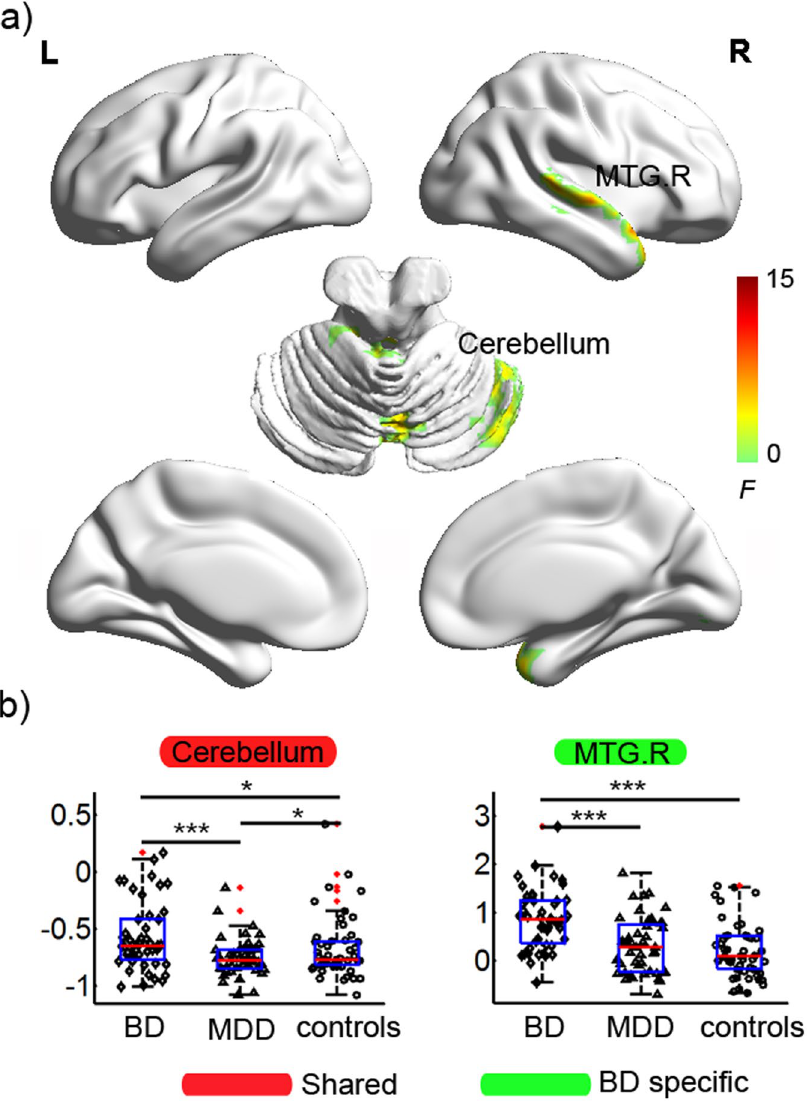
Figure 1. Statistical results for the lFCS in the BD, MDD, and healthy controls. ( a ) Clusters showing significant group effects ( p < 0.001 Alphasim corrected, ANCOVA). The brain surfaces were visualized using BrainNet Viewer (http://www.nitrc.org/projects/bnv/). ( b ) Post-hoc analyses of the lFCS for these significant clusters. The ‘BD’ type indicates that the lFCS in the cluster was specifically altered in the BD patients but not in the MDD patients. The ‘shared’ type indicates that the cluster with altered lFCS was detected in both the BD and MDD patients. ◊ , ∆ , and ○ in the scatter plot indicate the mean lFCS values of a given cluster for a subject in the BD, MDD, and control groups, respectively. Red dots indicate outliers. The box plot shows the median (red line), interquartile range (blue lines), and sample minimum and maximum values (dark lines). The horizontal lines on top indicate pairwise comparisons that survived statistical thresholds: *** p < 0.001; ** p < 0.01; * p < 0.05. Abbreviations: lFCS, long-range functional connectivity strength; BD (MDD), bipolar (major depressive) disorder; MTG, middle temporal gyrus; B (R), bilateral